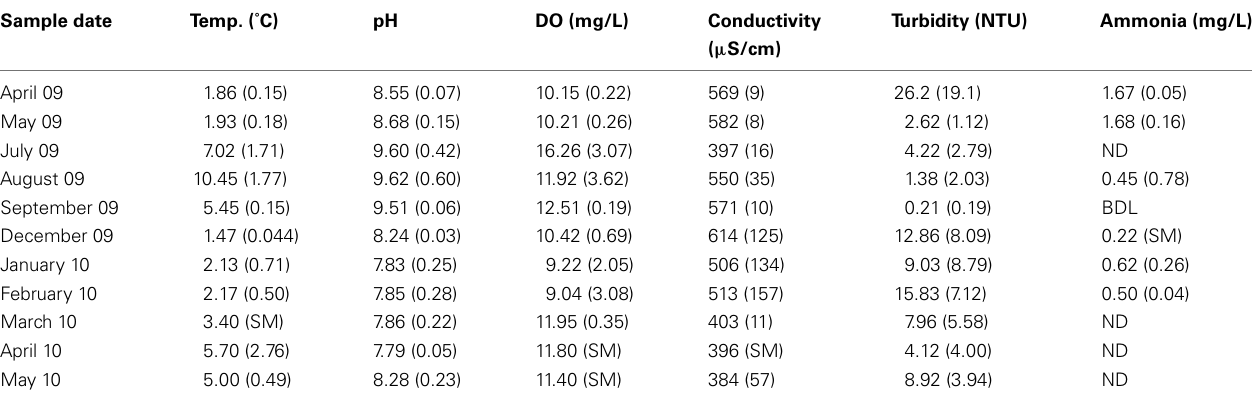
Table 3 | Physicochemical parameters of retention pond water.